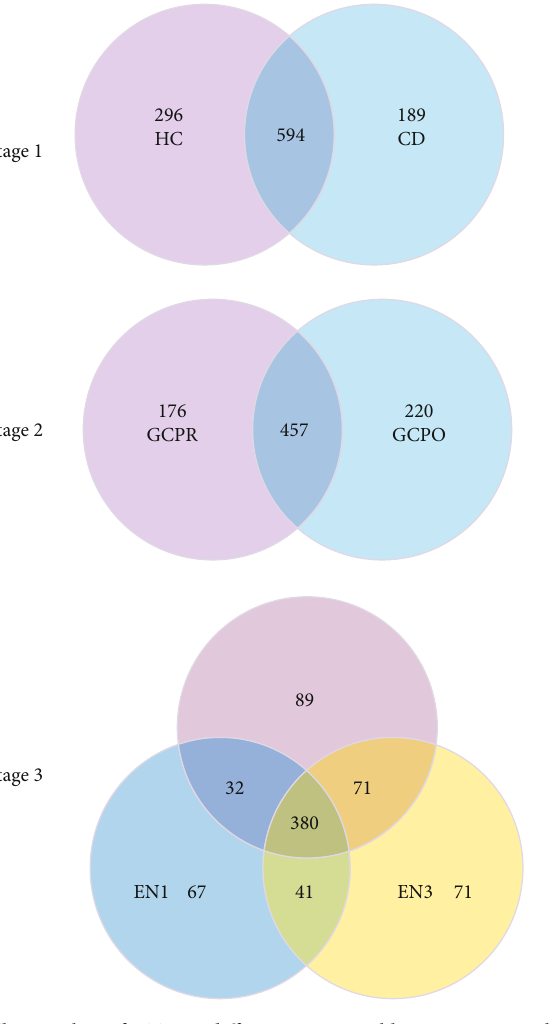
Figure 3: The number of OTU in di ff erent groups. Abbreviations: HC: health control; CD: Crohn ’ s Disease; GCPR: before corticosteroids treatment; ENPR: before EEN treatment; GCPO: after corticosteroids treatment; ENPO: after EEN treatment; EN0: 0 month after EEN treatment; EN1: 1 month after EEN treatment; EN3: 3 months after EEN